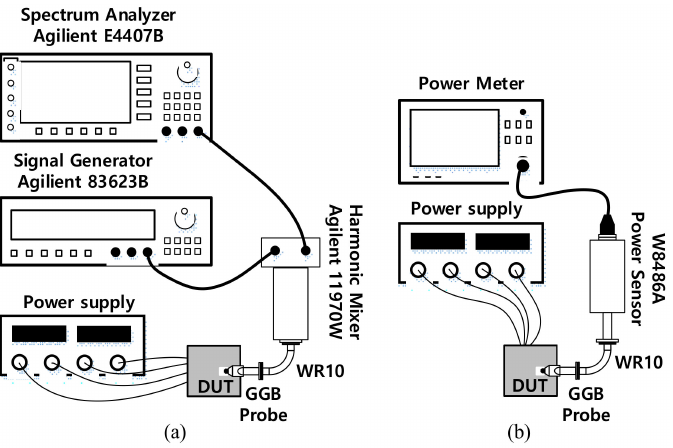
Figure 14. Measurement setups for the SA VCO: ( a ) frequency and phase noise ( b ) output power.